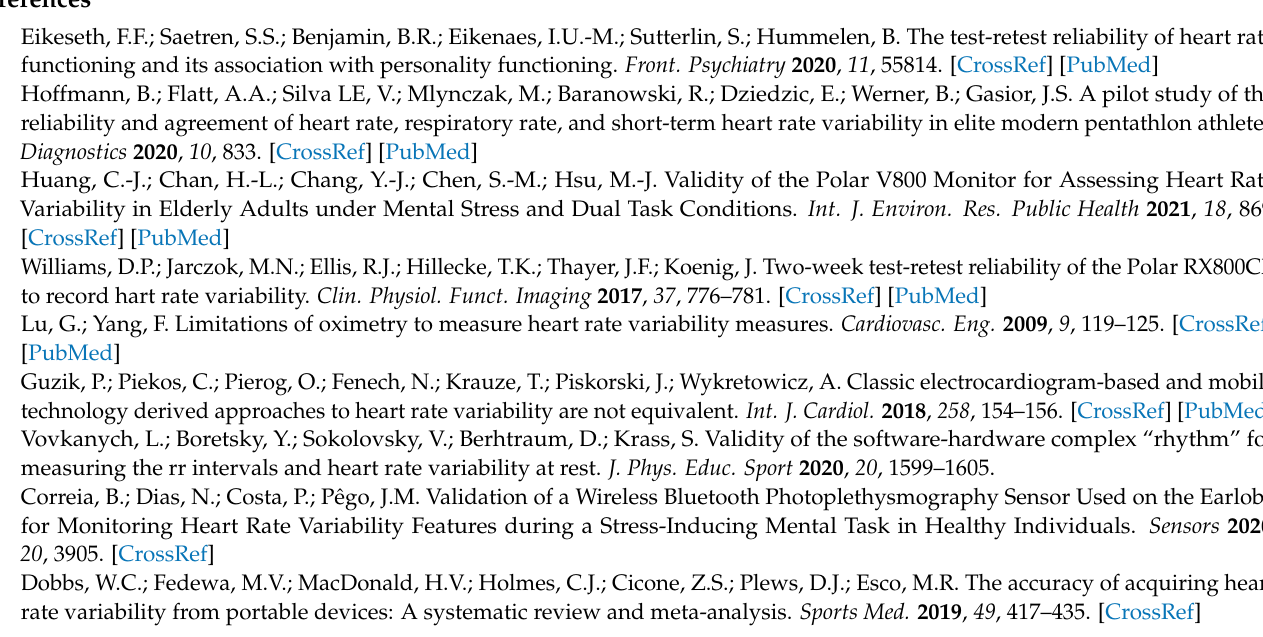
Table S5. Standard error of measurement; Table S6. Bland–Altman limits of